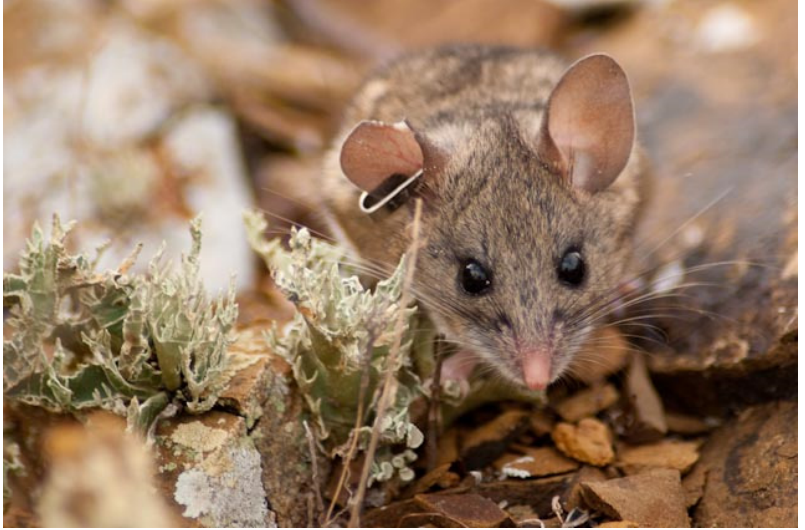
Figure 3. Cedros island cactus mouse ( Peromyscus eremicus cedrosensis ) invaded San Benito Oeste island in December 2006. Photo: © GECI/J.A. Soriano.